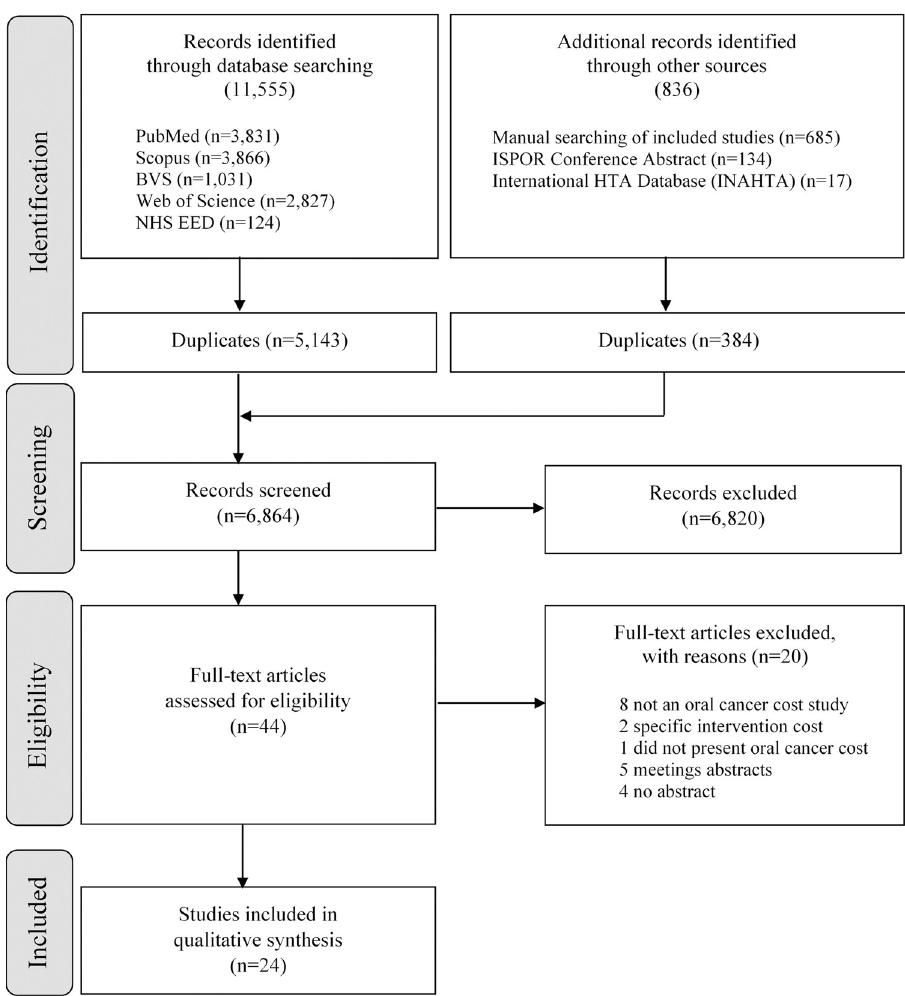
Fig 1. Data acquisition